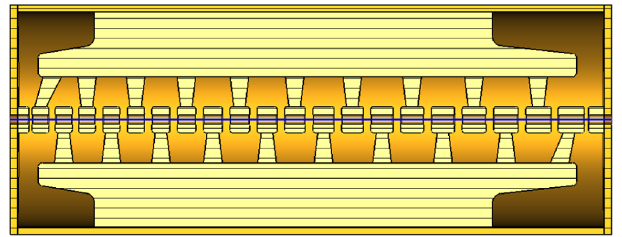
FIG. 12. Longitudinal vertical cross section of IH1 tank with the outer wall. The beam axis is shown by the blue line.